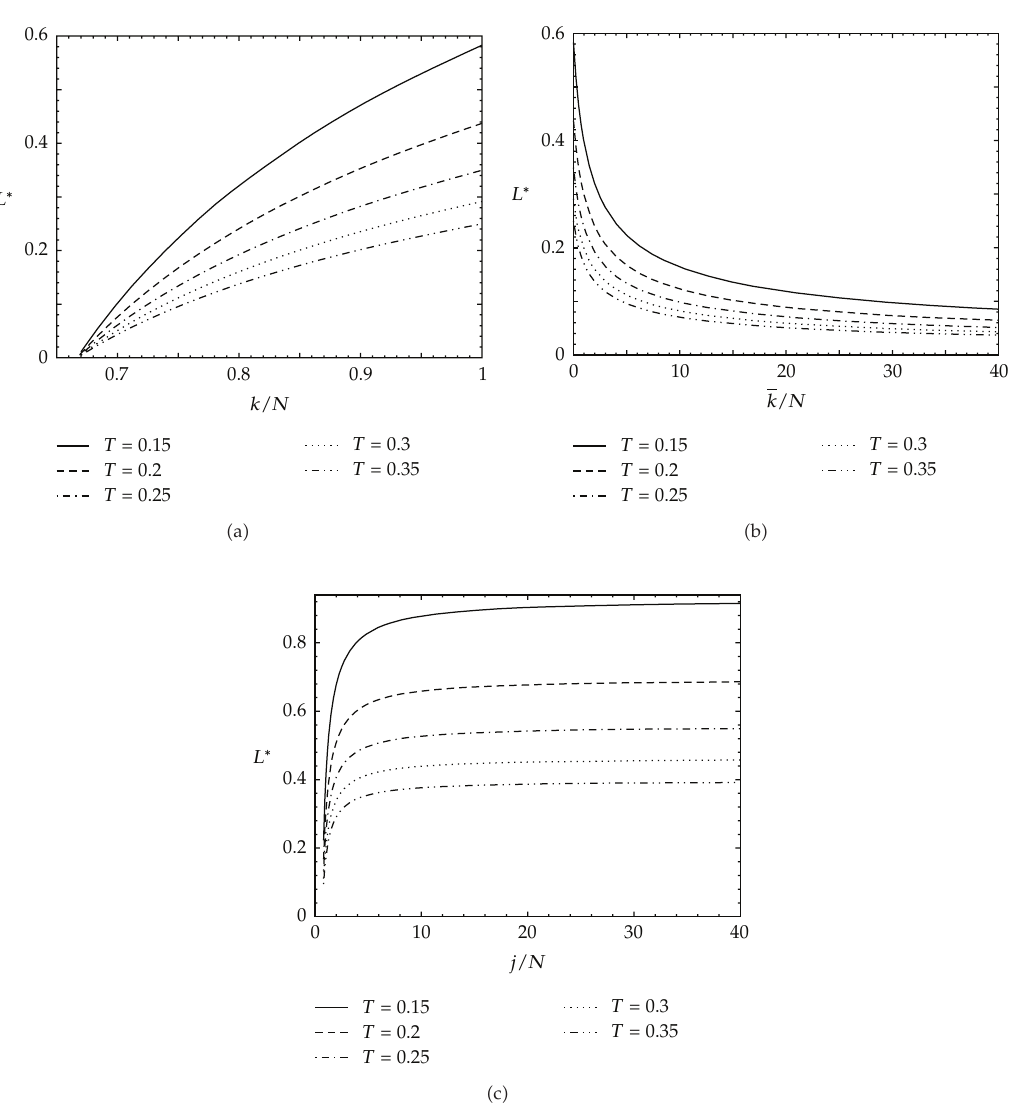
Figure 3: (cid:3) a (cid:4) the screening lengths of k -baryons with respect to k , (cid:3) b (cid:4) the screening lengths of (cid:3) N c (cid:9) k (cid:4) - baryons with respect to k , and (cid:3) c (cid:4) the screening lengths of j -mesonance with respect to j for T (cid:8) 0 . 15 − 0 .